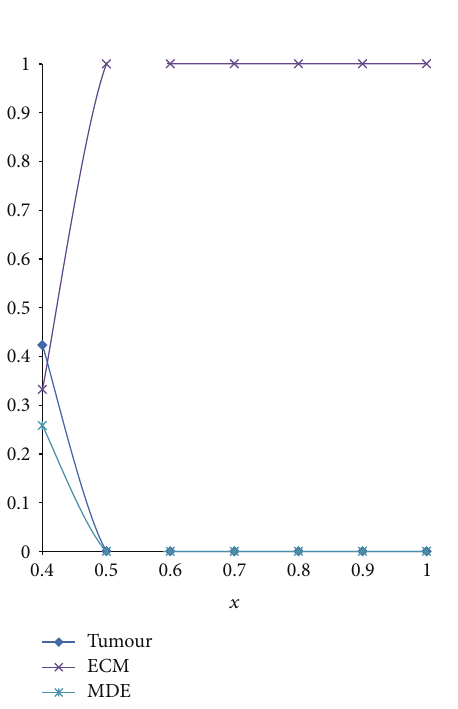
Figure 7: One-dimensional MDM and HPM solution of the system (3)–(5) with constant tumour cell diffusion showing the cell density, MDE concentration, and ECM density at 𝑡 = 20